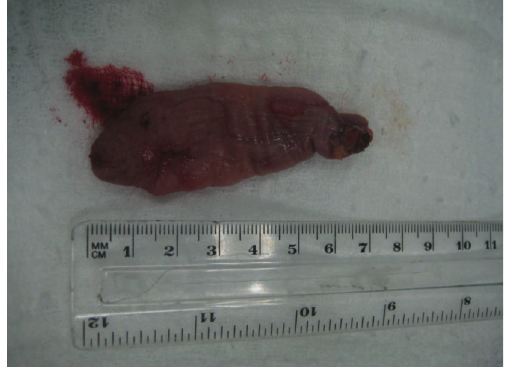
Figure 1: Protrusion of the mass with Valsalva.